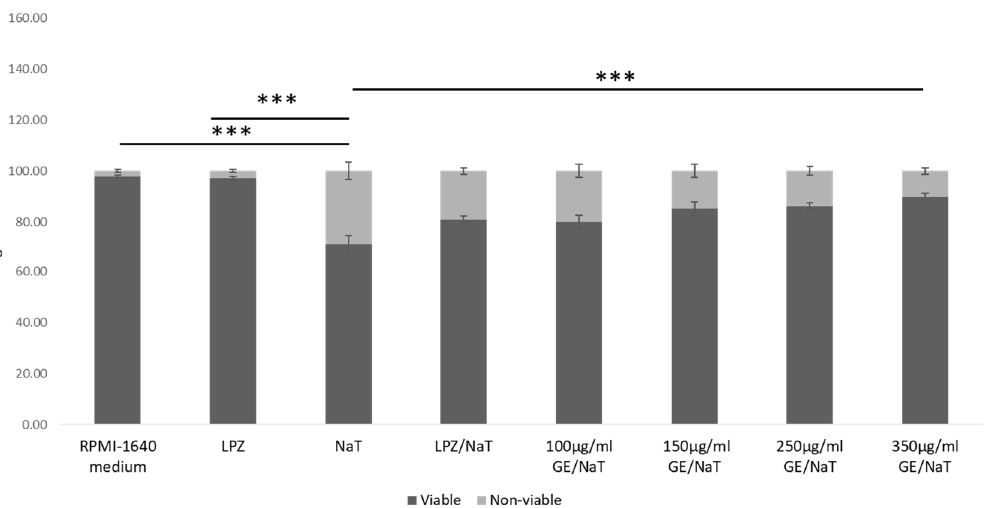
Figure 2. Effects of GE on the proliferation and apoptosis of AGS cell line . One way ANOVA F(7,23) = 19.78; p = 9.26 × 10 − 7 ; post hoc Tukey HSD. The values are represented as means ± SD. Bars assigned with asterisks are statistically significantly different (*** p < 0.001). The data shown are representative of at least three independent experiments. Human gastric cell line (AGS), sodium taurocholate (NaT/4 mM), lansoprazole (LPZ/10 µM), garlic extracts (GE/100, 150, 250 and 350 µg/mL).